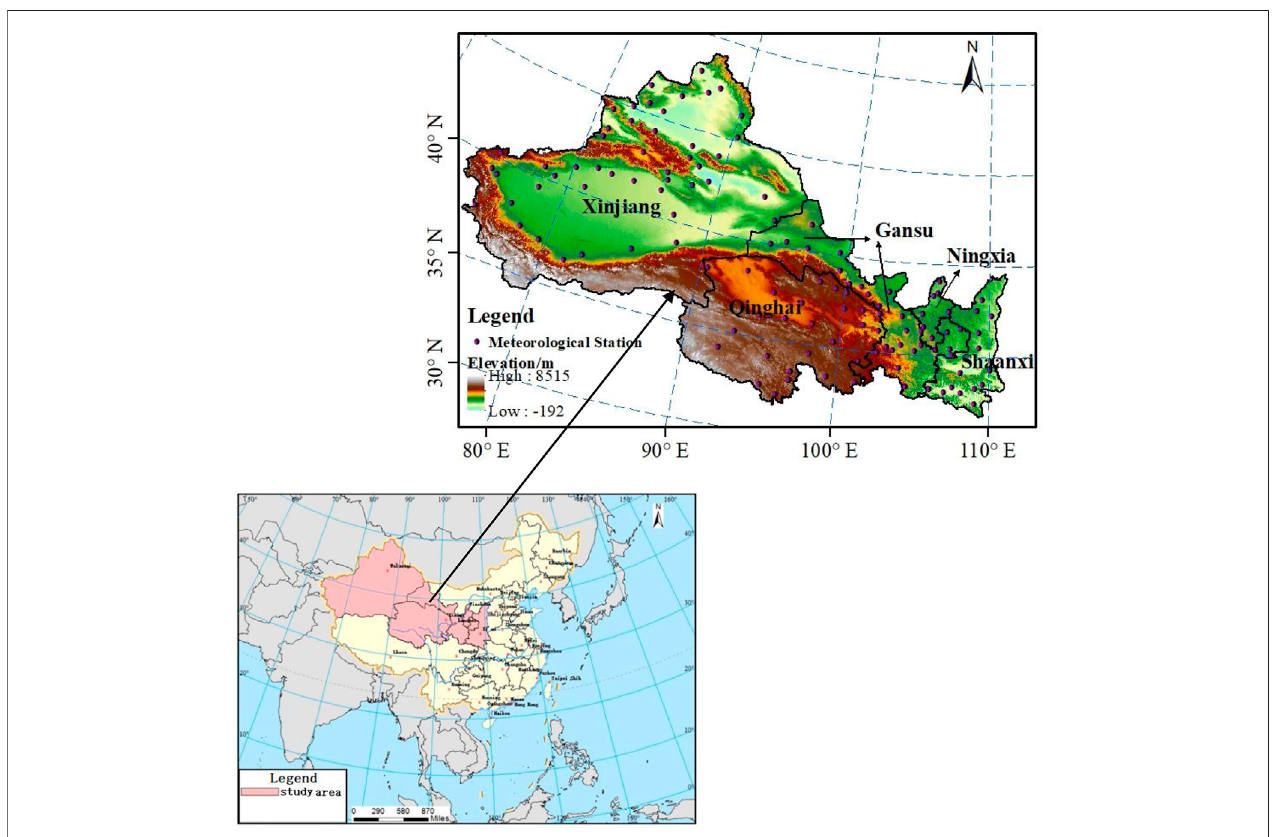
FIGURE 1 | Location and the meteorological details of the study